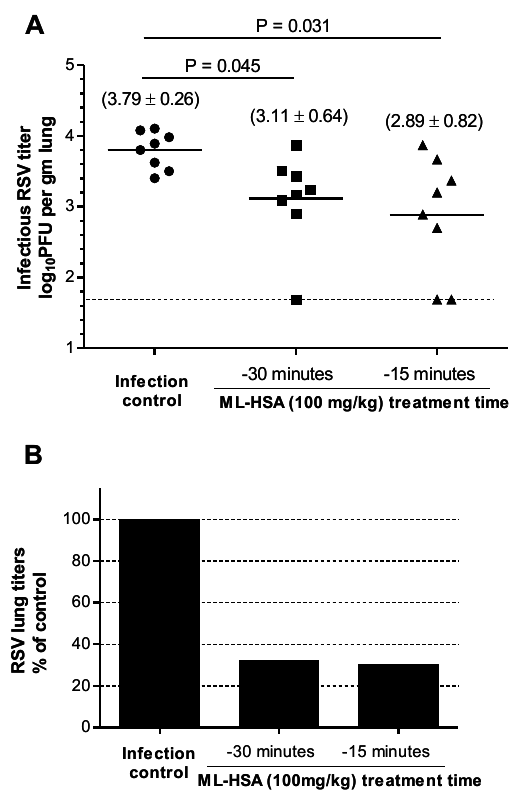
Figure 9. Prophylactic efficacy of ML-HSA against RSV infection in BALB/c mice. ( A ) ML-HSA (100 mg/kg) was administered 15 and 30 min, respectively, before RSV intranasal inoculation. The infectious RSV lung titer in the mouse lung was expressed as the log10 PFU per gram of lung tissue. Each data point represents the RSV titer for each individual animal in the respective treatment cohort. The horizontal line, drawn in each cohort, marks the geometric mean RSV titer of the group. The horizontal hatched line, across the graph, represents the RSV titer at the limit of assay detection. ( B ) Percentages of viral titer (geometric mean) in the lungs of ML-HSA - treated cohorts relative to infection control group (without ML-HSA